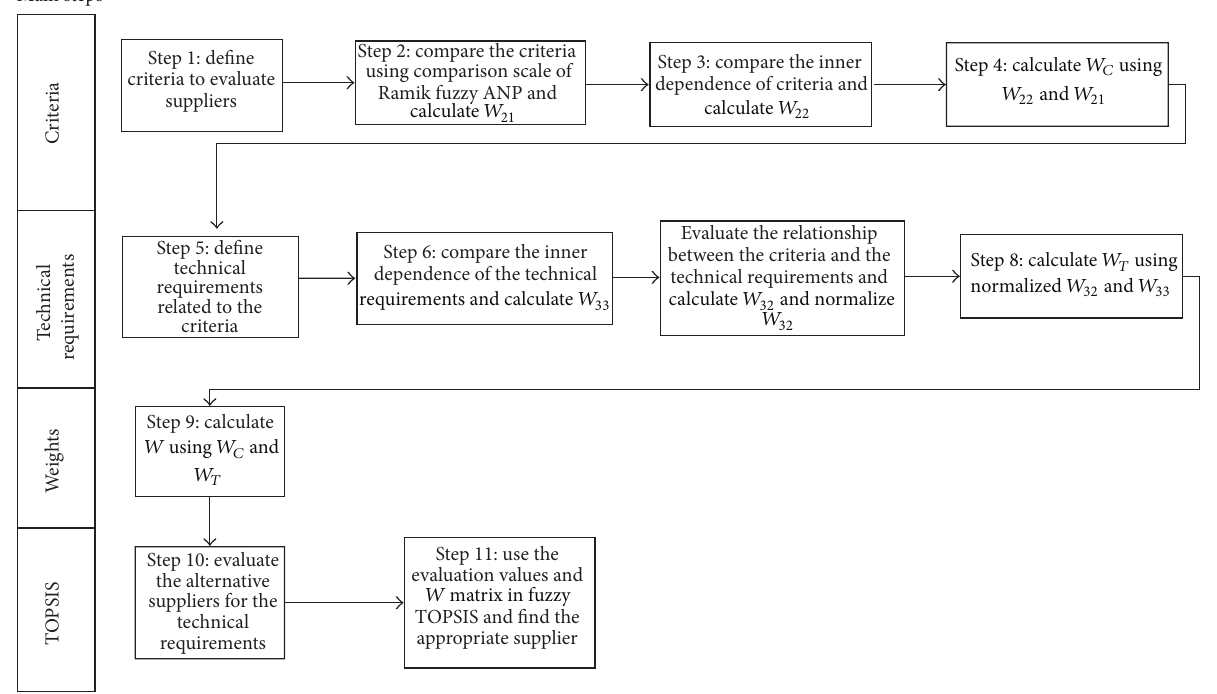
Figure 4: The flowchart of the proposed methodology.